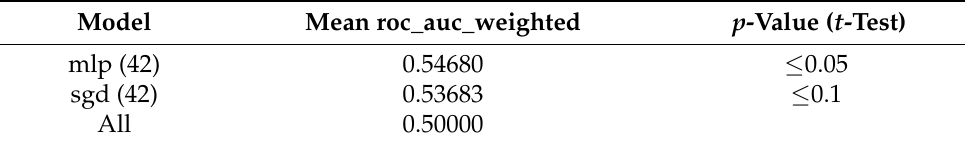
Table A10. Models with significantly better mean ROC (auc)